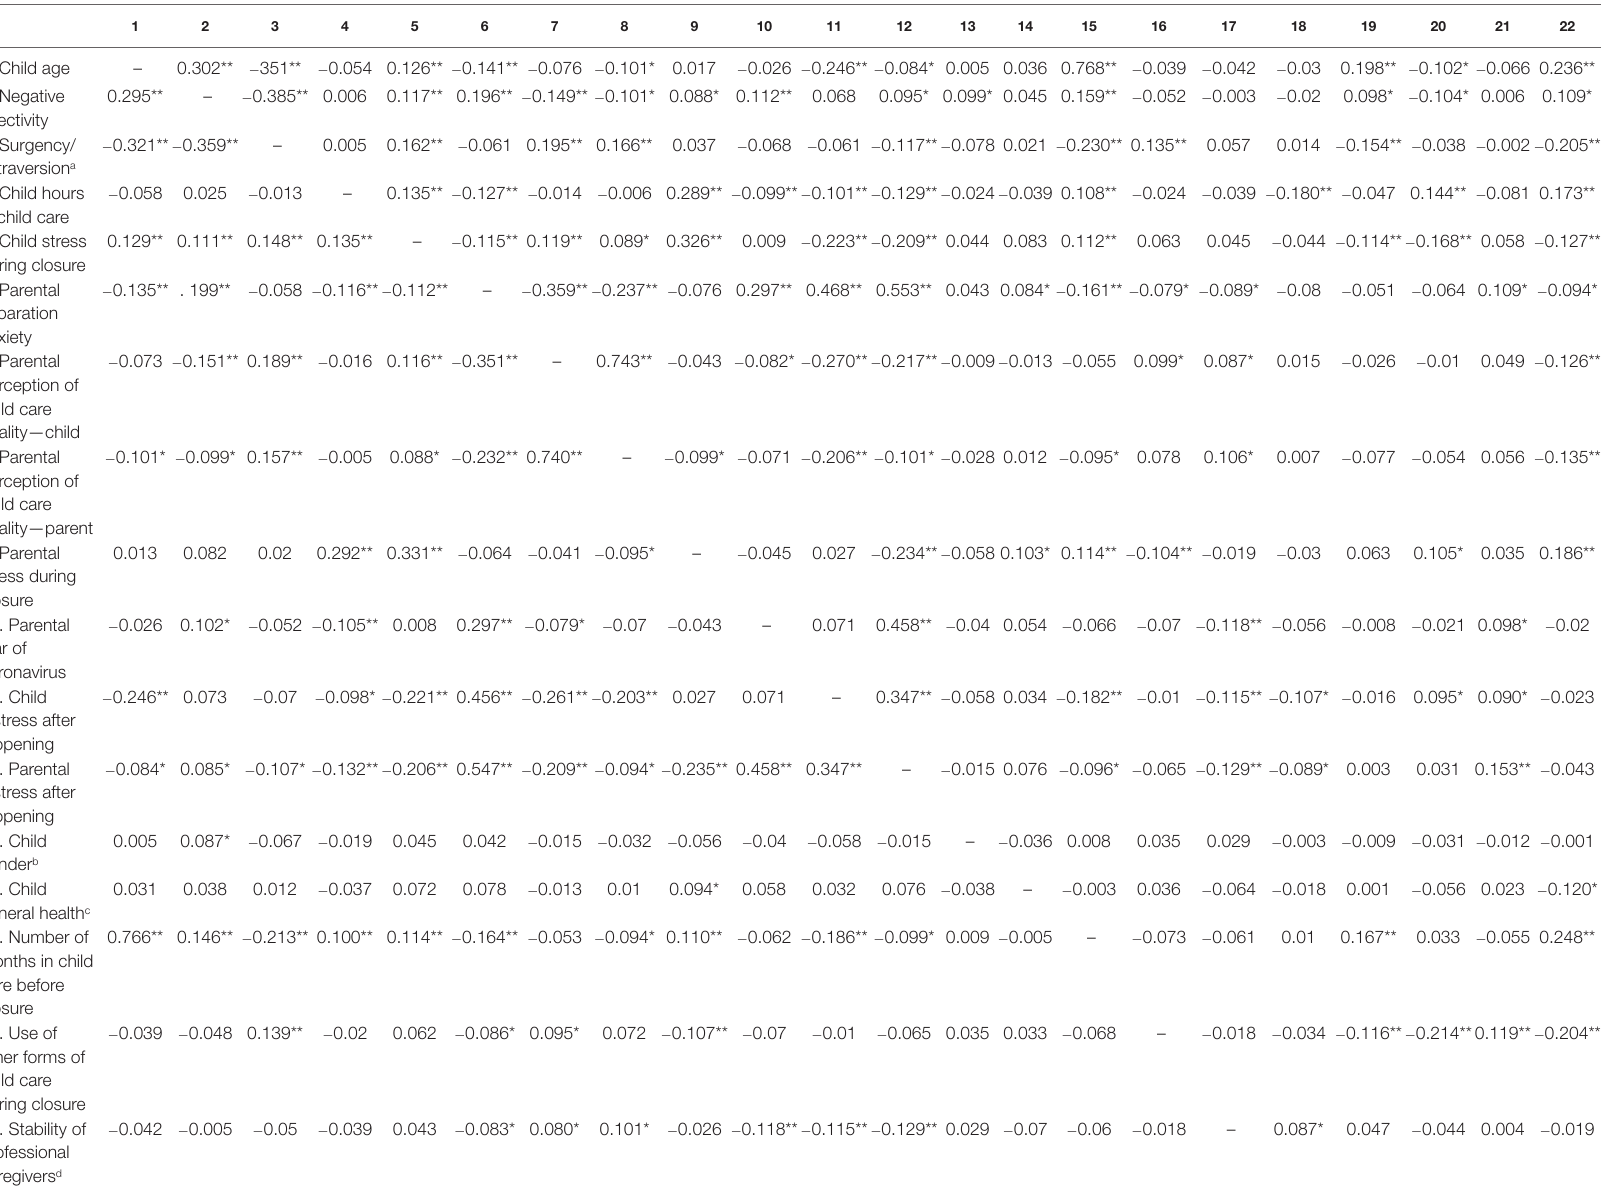
TABLE 2 | Bivariate correlations among the predictors, outcome variables, and